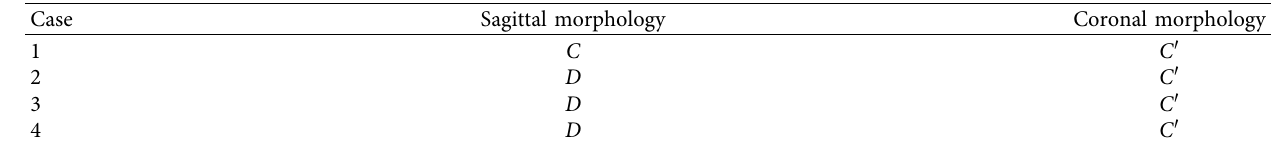
Table 7: Morphology types in the perforation